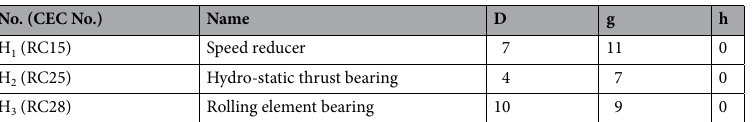
Table 9. Real-world constrained optimization problems. D dimensions, g number of inequality constraints, h number of equality constraints.